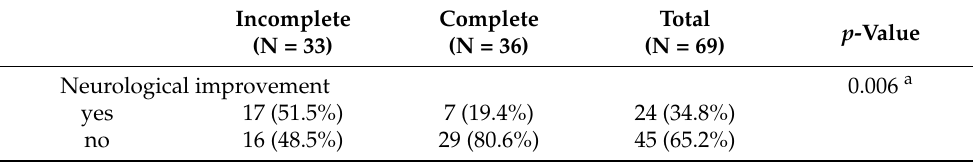
Table 4. Influence of severity of TSCI on neurological